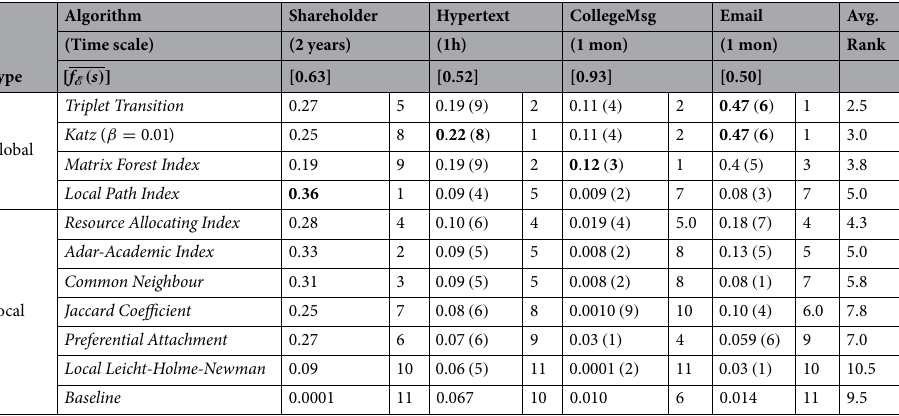
Table 5. Summary of the average precision scores (on the left) and their ranks (on the right) for selected (cid:31) t based on k-means clustering. The errors quoted are standard deviations from all the computed network snapshots of the selected time scale, except for theTurkish Shareholder networks which have one prediction for three